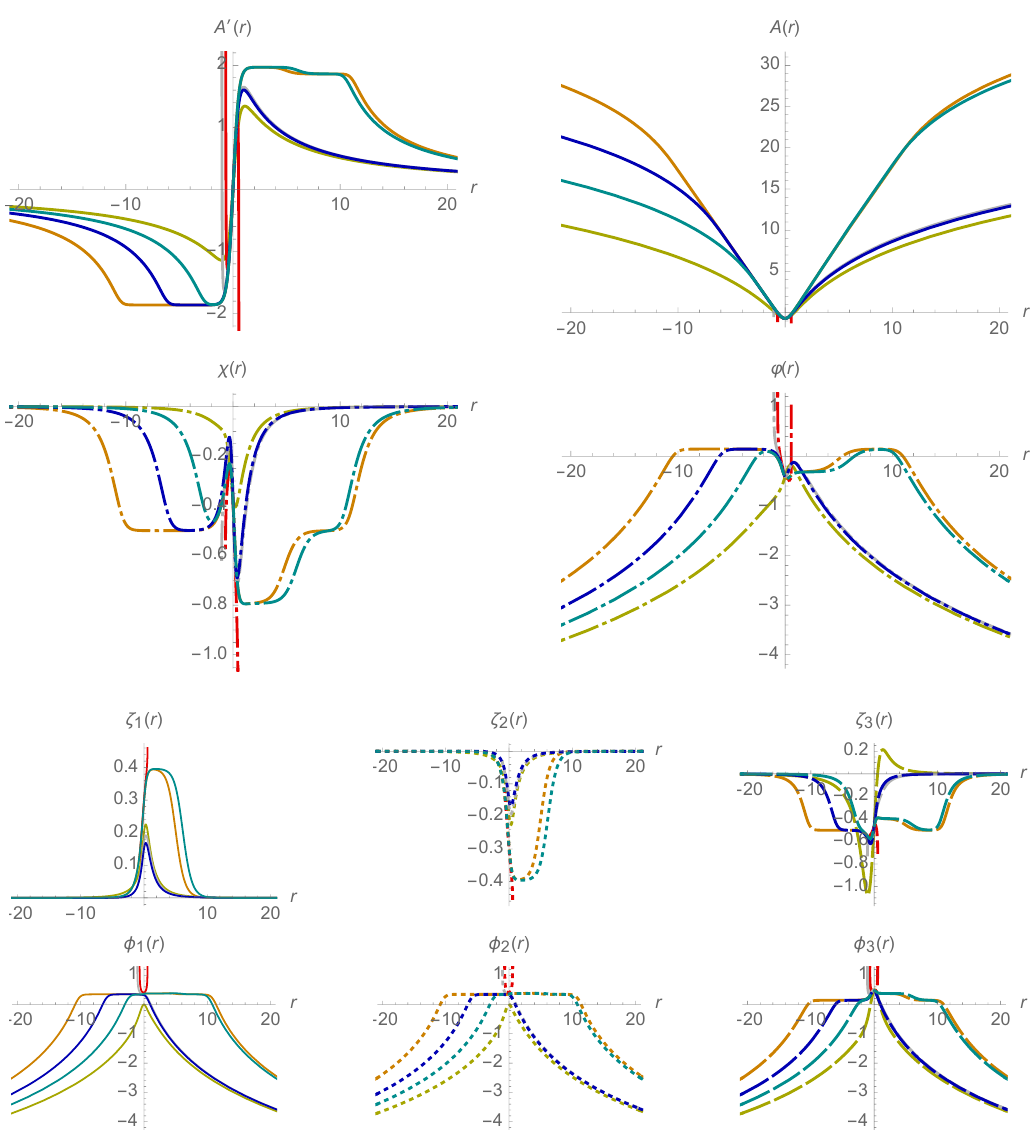
Figure 4. Examples of supersymmetric Janus solutions interpolating between N = 8 SYM (yellow) and between SYM and a singularity (grey). The red line represents a singular solution interpolating between two singular geometries on both sides. The solution shown by the orange line describes an SO(4) / U(3) conformal interface within the N = 8 SYM theory. The blue and green lines correspond to SYM/ U(3) and SYM/ SO(4) Janus solutions,